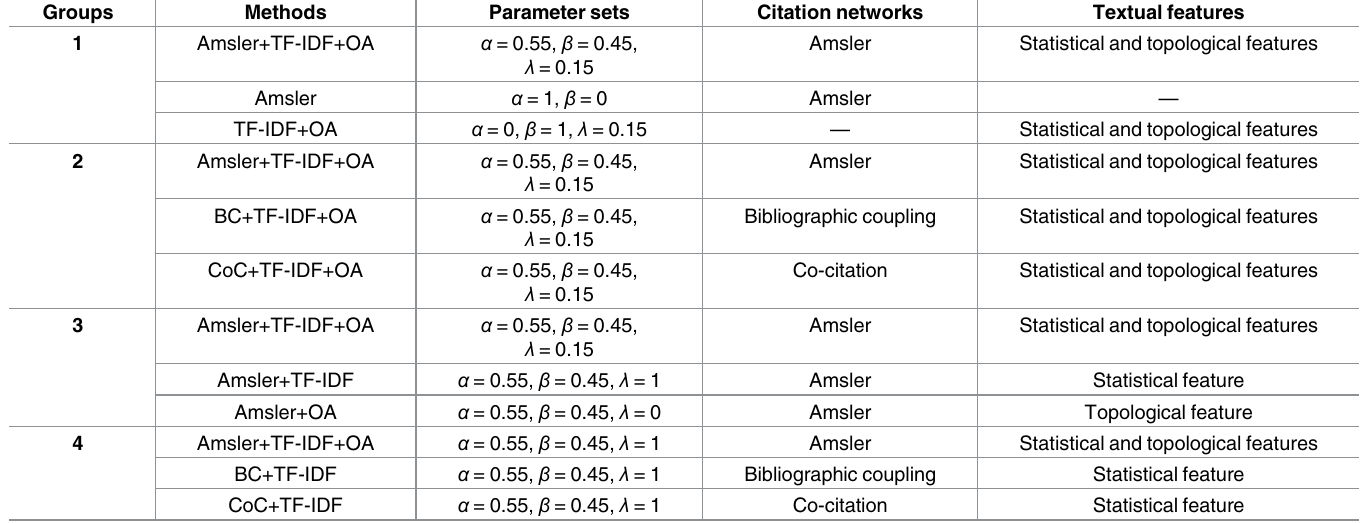
Table 3. Different clustering methods with different parameter settings.